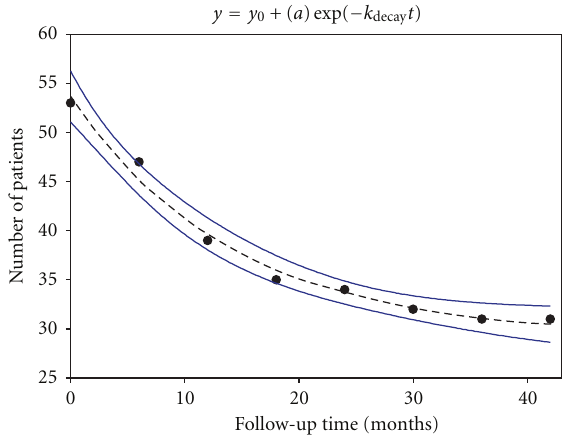
Figure 3: Time course of recurrence of CAF symptoms in some patients (22 of 53) in a 42-month follow-up study [55]. Initially ( t = 0, i.e., 6 months after injection), all 53 patients were symptom- free for 6 months after injection of 10–20 U BOTOX. The fitted values from (2) (see text) are y 0 = 29 . 2, a = 24 . 4, and k decay = 0 . 85 years − 1 . The y -axis represents the number of symptom-free patients. Dashed line is fitted data; solid lines are 95%